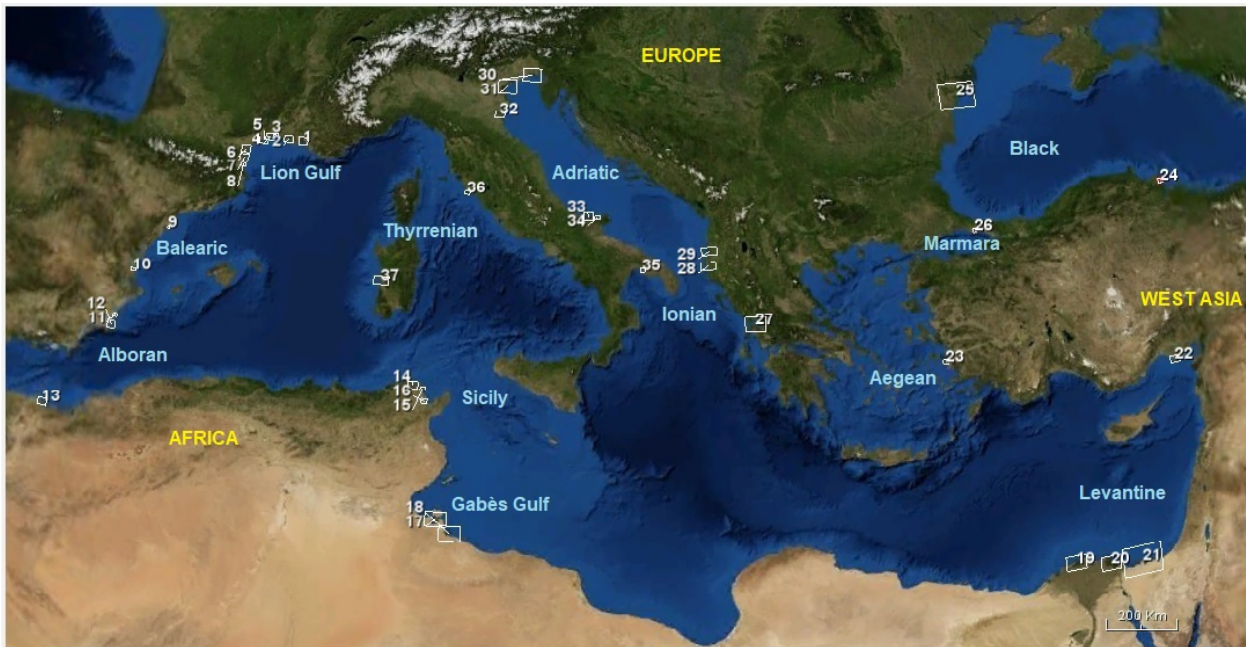
Figure 3. Location of Mediterranean Sea basins and coastal lagoons, indicating their numerical code according to Table 1. Base map source: GlobeView (https://globeview.nepia.com/, accessed on 15 January 2022).